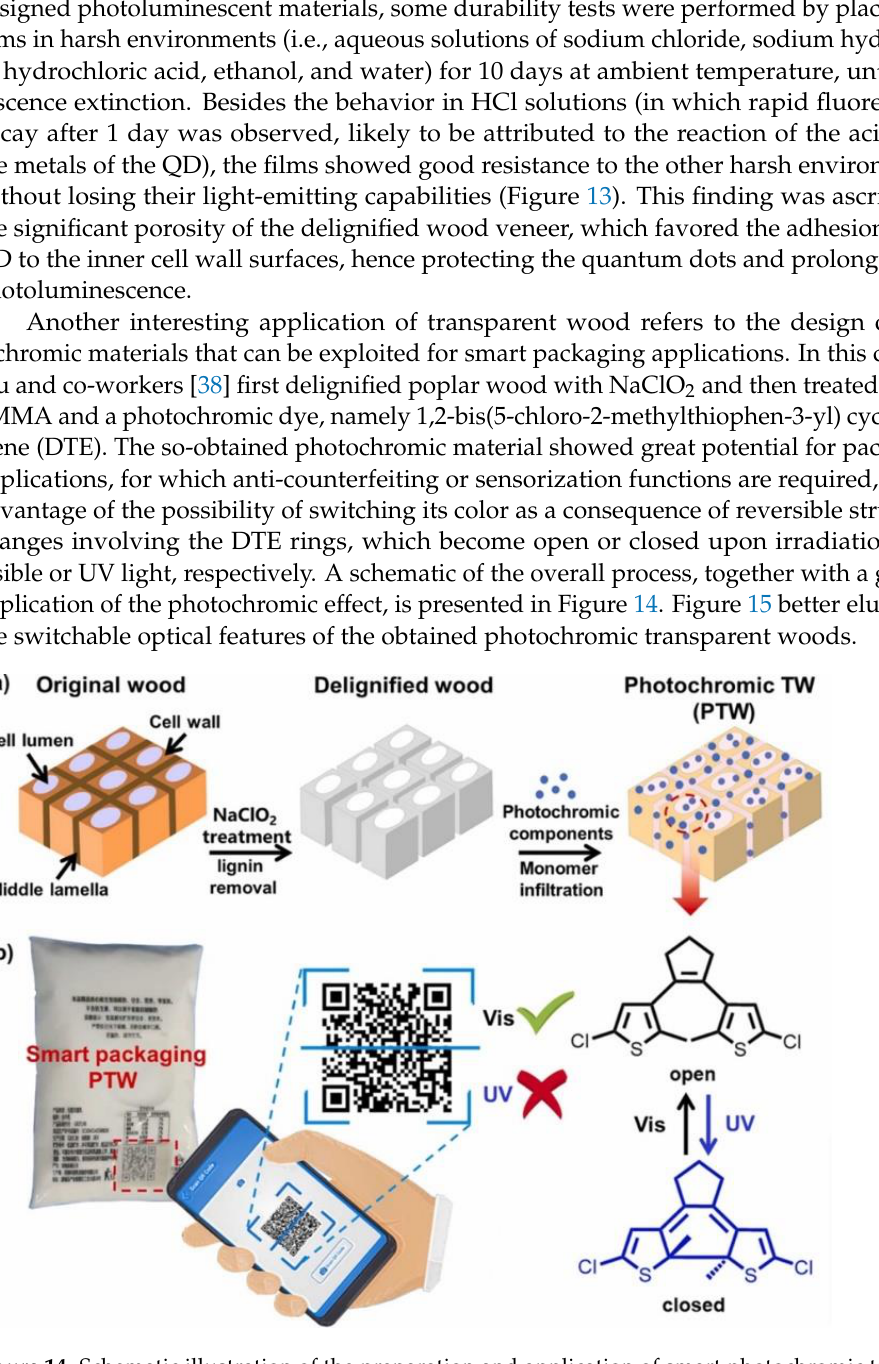
Figure 14. Schematic illustration of the preparation and application of smart photochromic transparent wood (PTW). ( a ) The fabrication process of the PTW. ( b ) Potential smart packaging applications of PTW. Reprinted with permission from [38], copyright 2022, Elsevier.